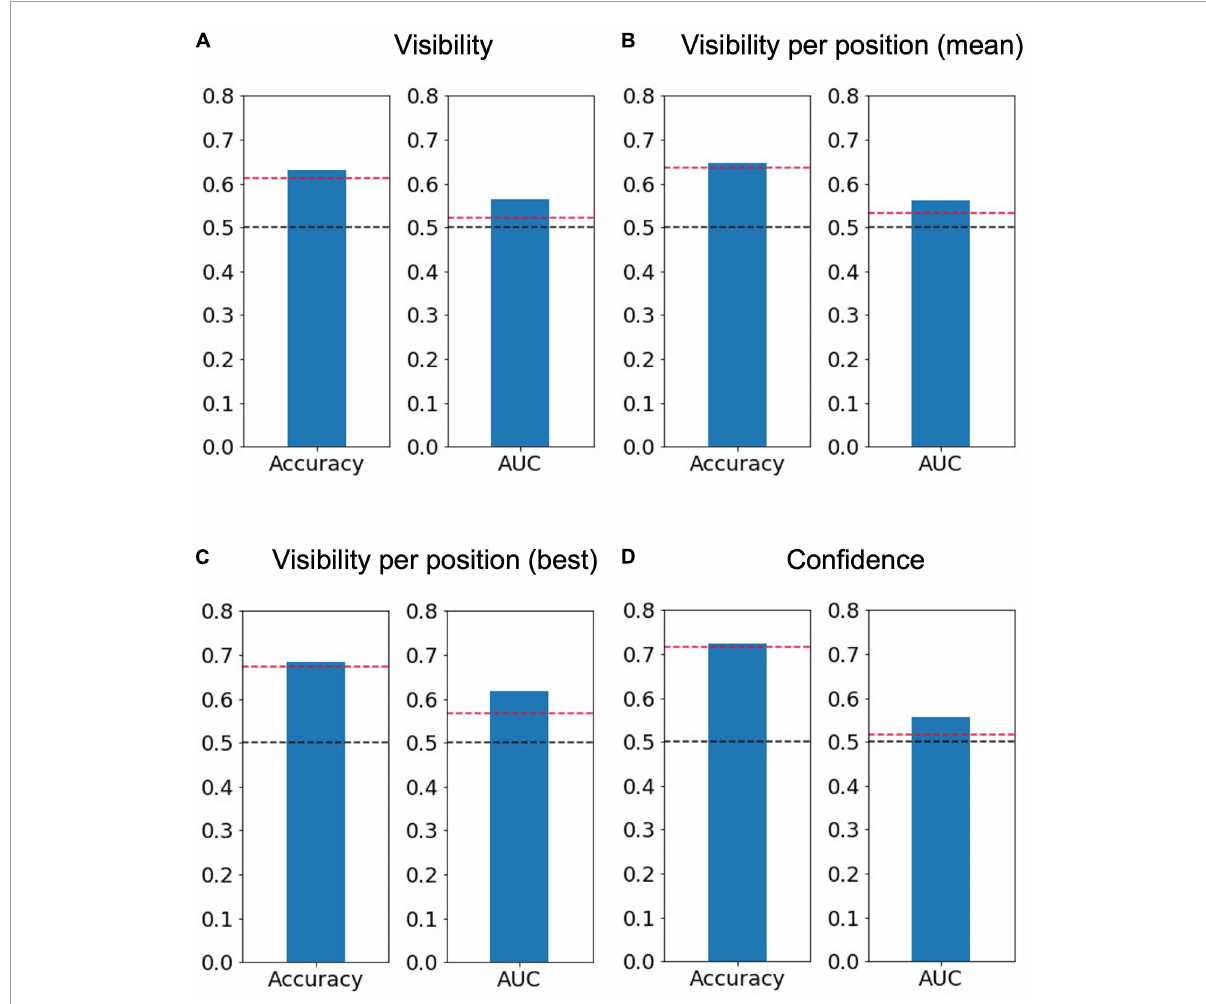
FIGURE4 Average decoding accuracy and area under the receiver operating characteristic curve (AUC). Averaged accuracy across participants of (A) the perceptual-decision (“yes” vs. “no”) decoding calculated using both positions of interest ( N = 7), (B) that calculated separately for the two positions of interest and then averaged ( N = 7), (C) that for the best position when the trials were separated based on the target position ( N = 7, top left for three participants and bottom right for four participants), and (D) confidence (“sure” vs. “maybe”) decoding ( N = 6). The dashed red lines represent a significance level of 0.05 based on the permutation test, while the dashed black lines represent